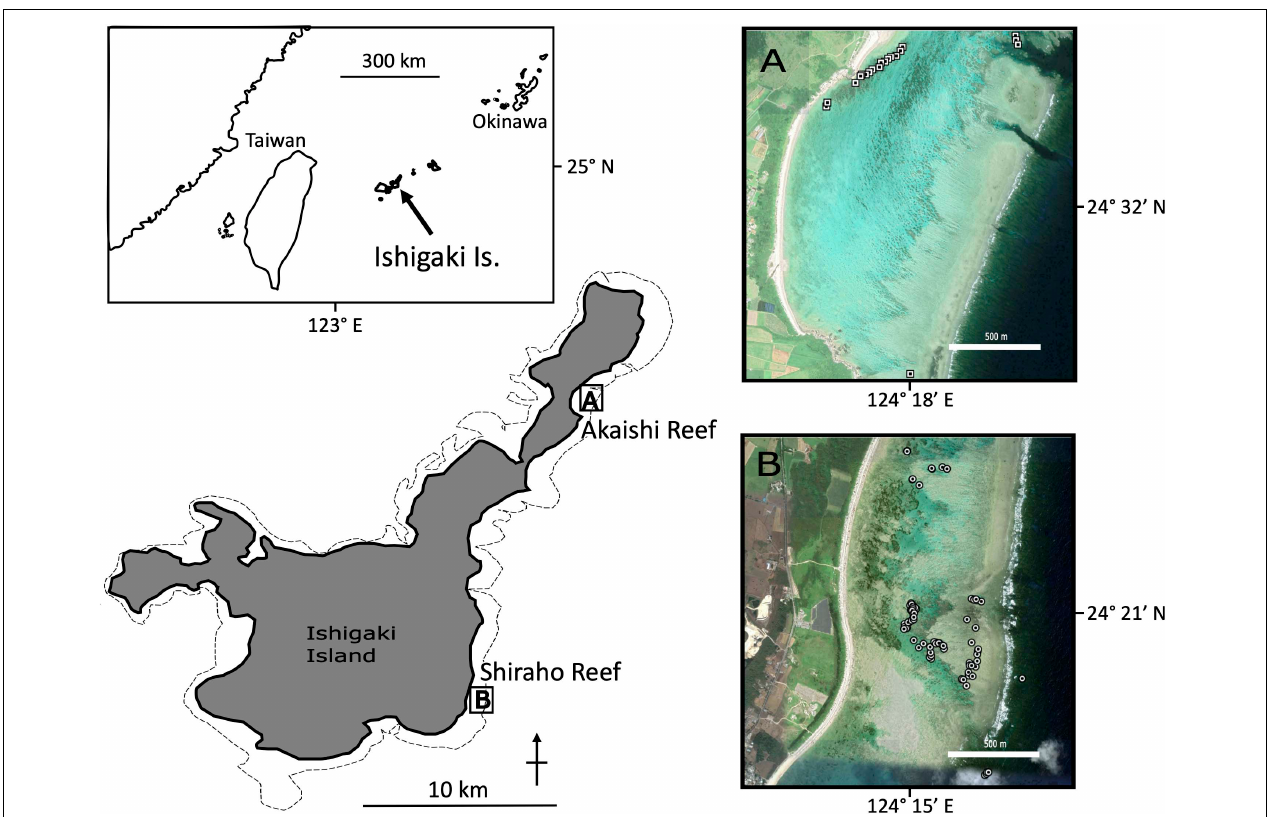
FIGURE 1 | Map of sampling locations for H. coerulea . Each circles in (A) Shiraho reef and (B) Akaishi reef indicate the sampling points for individuals. The corresponding GPS coordinates can be found in Supplementary Materials .